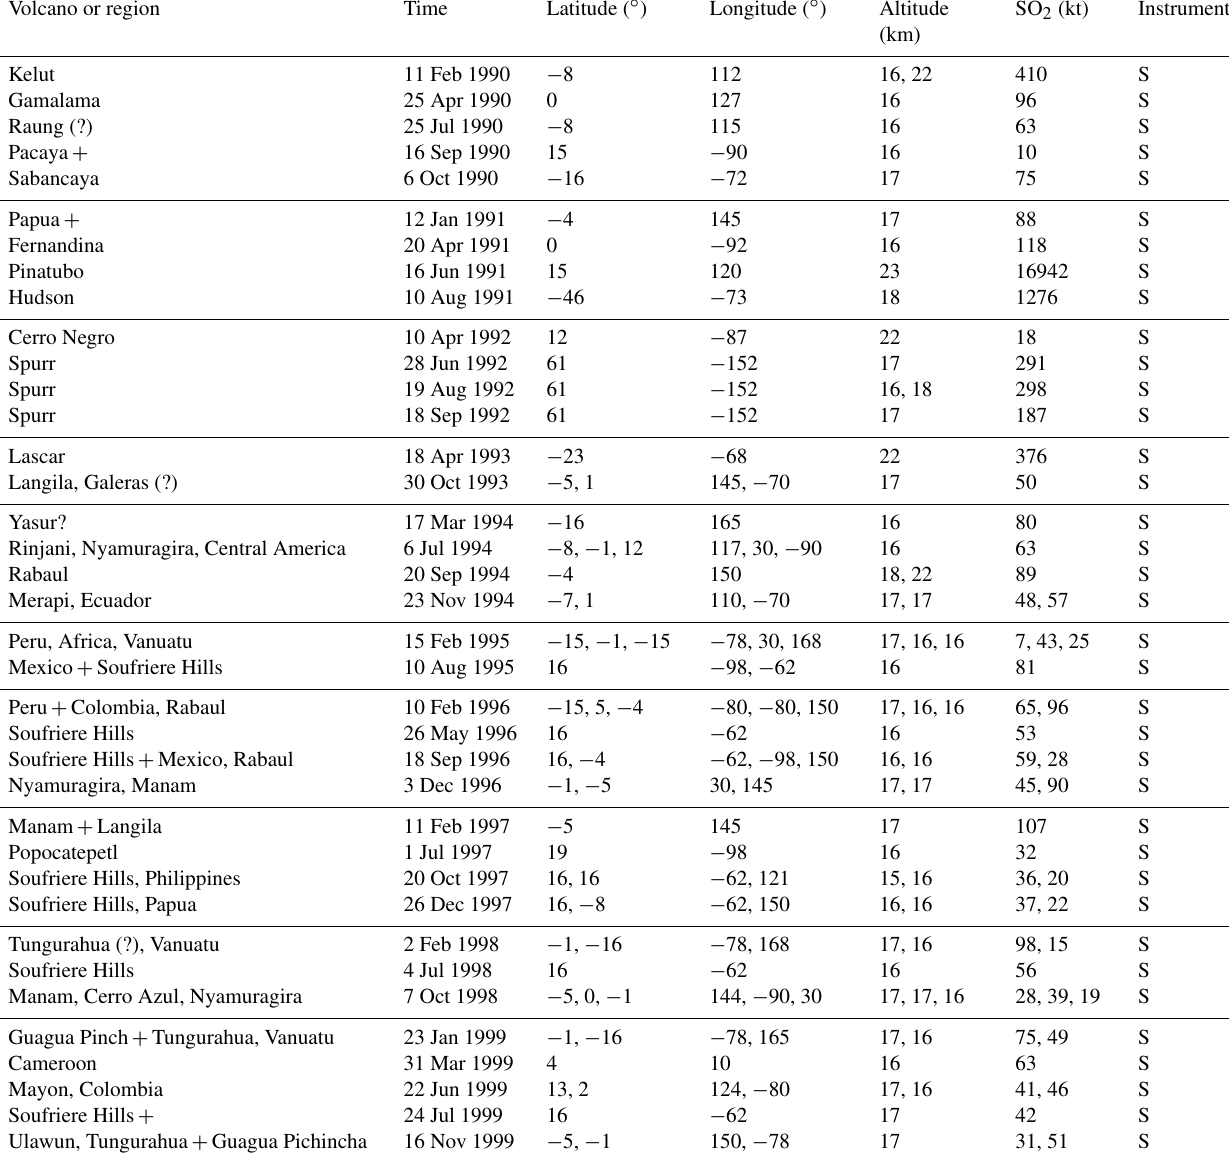
Table 2. Inventory of volcanic SO 2 emissions into the stratosphere integrated over latitude belts above 14km at low latitudes, 13km at mid latitudes and 12km at high latitudes from the three-dimensional mixing ratio perturbations. Listed altitudes and latitudes represent the region of maximum mixing ratio perturbation, and the altitudes are close to the top injection height. For some eruptions, two plumes at different altitudes were identified, and the listed mass is the sum – derived from satellite data (2002–2012) by MIPAS (M) and GOMOS (G) and based on a previous study by Brühl et al. (2018) with scaling factors for T63 and already published in an earlier version in Bingen et al. (2017) ( volcano names in italic ). Extended with satellite data from SAGE II(V7.00) (S) back to 1990–2002 and from 2012 to 2019 by OSIRIS (O). Sometimes TOMS/OMI/OMPS (T) are also used for handling data gaps. For a detailed description, see the text. Data available online as a Fortran-formatted ASCII table and the three-dimensional data as netcdf (https://doi.org/10.26050/WDCC/SSIRC_3, Brühl et al.,